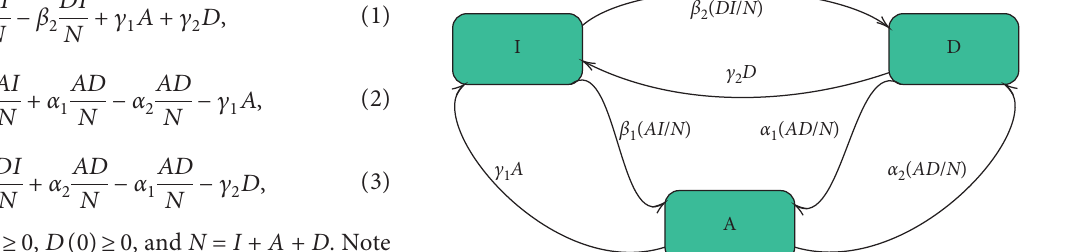
Figure 1: Flowchart for models